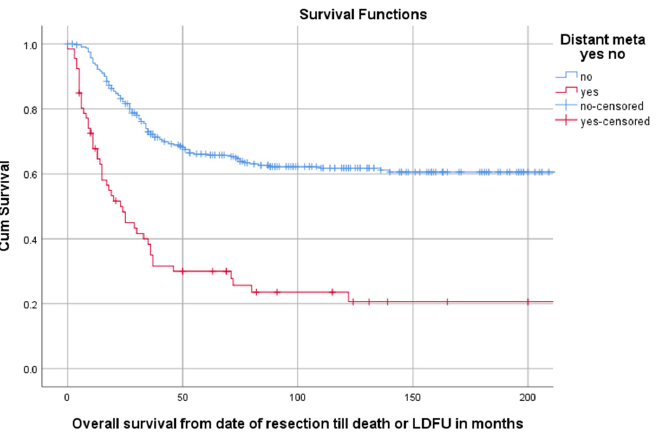
Figure 3. KM estimation of OS in the total cohort (upper panel) and of patients with and without distant metastasis (lower panel). Legend: OS = overall survival, DM = distant metastasis at presentation, cum survival = cumulative survival, LDFU = last date of follow-up.